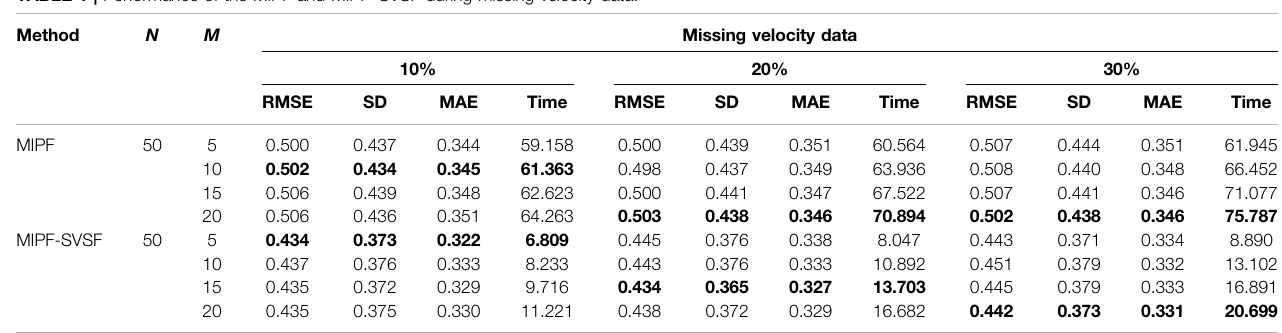
Bold values represents the smallest value among variables (RMSE SD MAE Time).